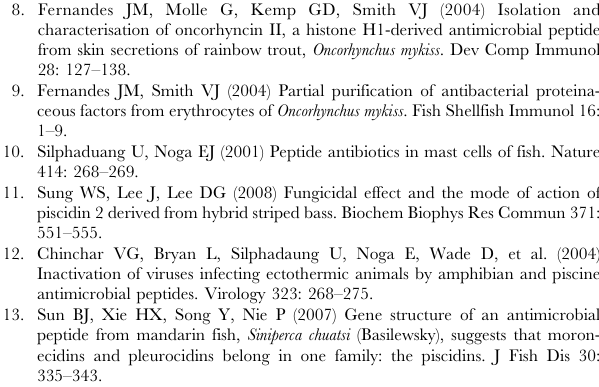
Figure S1 (A) Codon aligned multiple sequence alignment of piscidin nucleotide sequences corresponding to signal and mature peptides (46 codons). The pro-domain was too divergent to be included in the maximum likelihood analyses of positive selection. (B) ClustalW multiple sequence alignment of the corresponding putative peptides. Figure S2 Reconstruction of piscidin phylogeny. This phylo- gram was constructed using Bayesian and likelihood methods. The SYM + G model was selected for the Bayesian analysis and the consensus tree was built after burning 1,250 trees from the 5 N 105 generations. The likelihood phylogeny was obtained with a HKY nucleotide substitution model with a discrete c distribution (4 categories, c shape parameter 2.0) and 100 bootstrap data sets. Bayesian posterior probabilities and maximum likelihood boot- strap values are indicated as percentages above and below the tree nodes, respectively. The scale bar indicates distance (branch